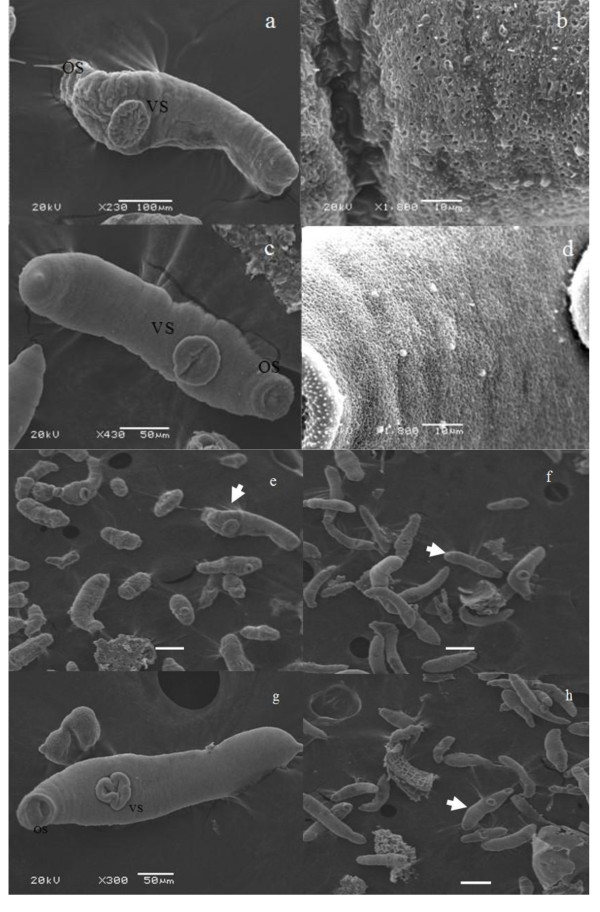
Scanning electron microscopy. Scanning electron microscopy (SEM) of schistosomula from Wistar Rat (a, b and e), from BALB/c mice (c, d and f) and rabbits (g and h): Os, oral sucker; Vs, ventral sucker. An overall wrinkled (a) and at higher magnification pitted (b) appearance is noted in schistosomula for Wistar rat hosts.(e, f and h Bar = 200 μm).